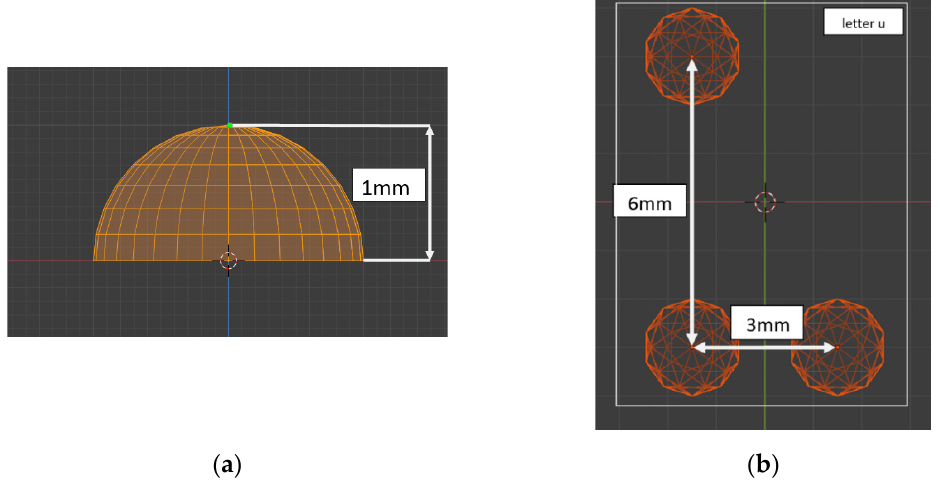
Figure 7. Preview of the preparation of letters in Blender and dimensioning: ( a ) a single element for creating letters; ( b ) letter “u”.